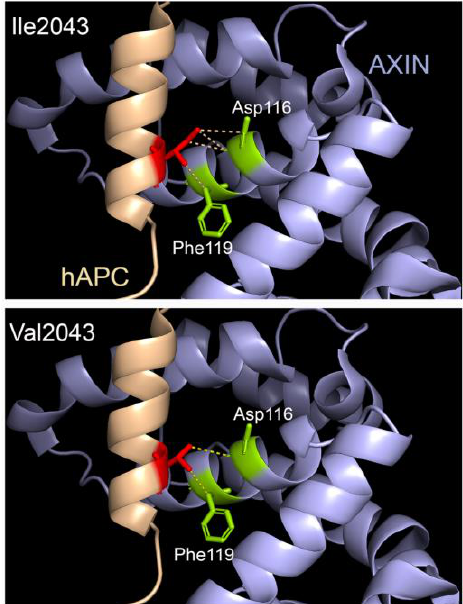
Figure 5. The Ile2043Val missense variant in the SAMP3 domain of APC may impact the strength of interaction with AXIN. Human APC SAMP3 domain is shown in beige while the RGS domain of AXIN is coloured mauve. Isoleucine 2043 in wildtype human APC has four contacts with the AXIN RGS domain: three with Asp116 and one with Phe119. The valine substitution in APC is predicted to reduce the contacts with Asp116 to just